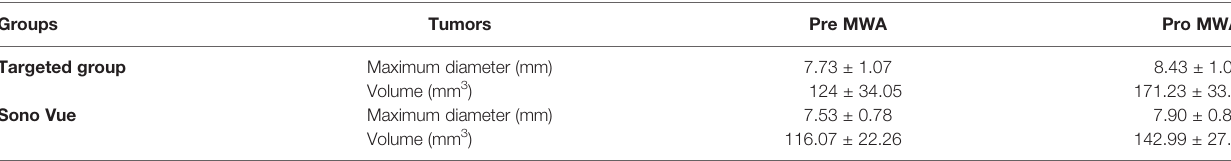
TABLE 1 | Changes of 4T1 breast tumors in nude mice before and after MWA.